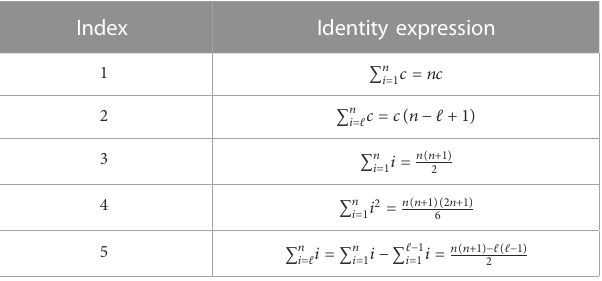
TABLE 2 Useful fi nite sum identities.